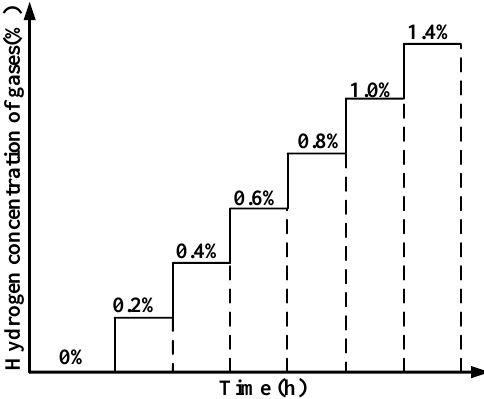
Figure 6. Test program of different hydrogen concentrations.